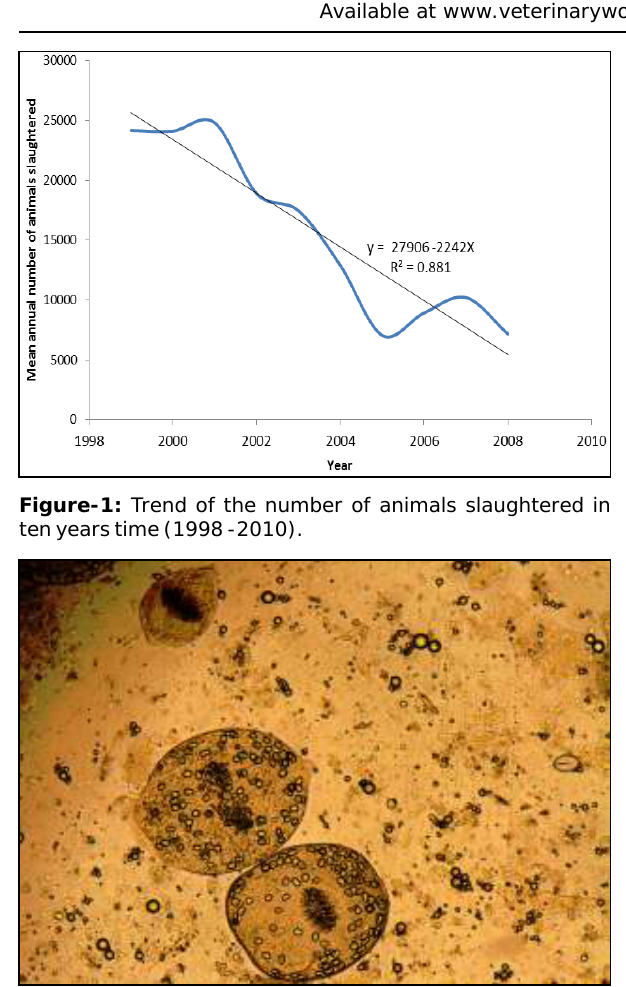
Figure-4: An increasing trend of the prevalence of Hydatidosis in ten years (1999-2008).